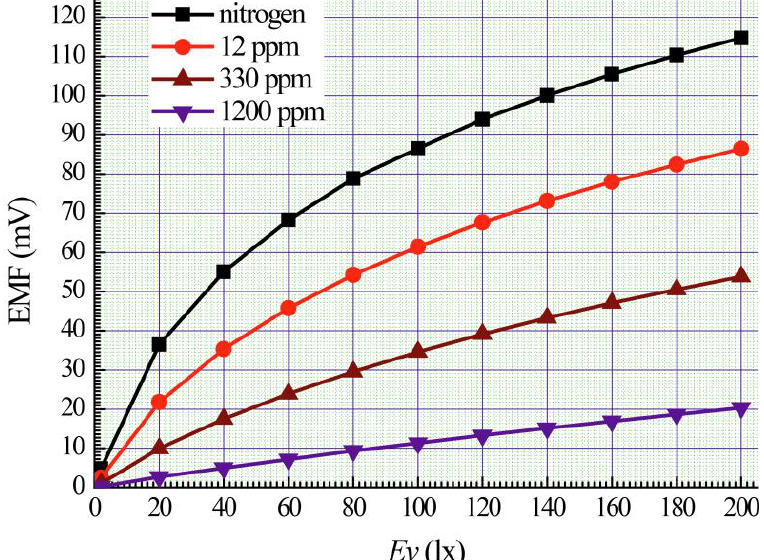
Figure 3. Dependences of maximal magnitudes of Photo-EMF on illumination level under nitrogen and different concentrations of